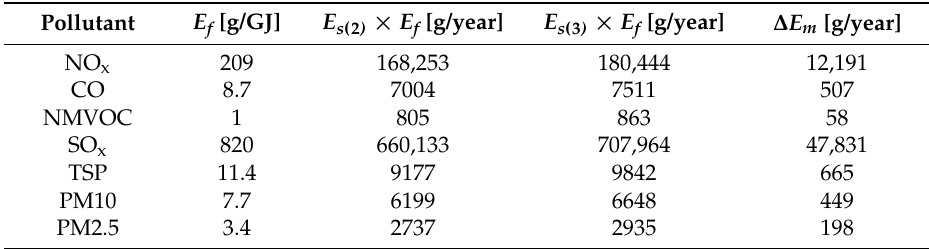
Table 3. The results of calculations for the reduction of pollutant emissions into the air as a result of a change in the distance between the supply and return pipes from s ( 2 ) = 0.03 to s ( 3 ) = 0.035 for circular thermal insulation. Pollutant E f